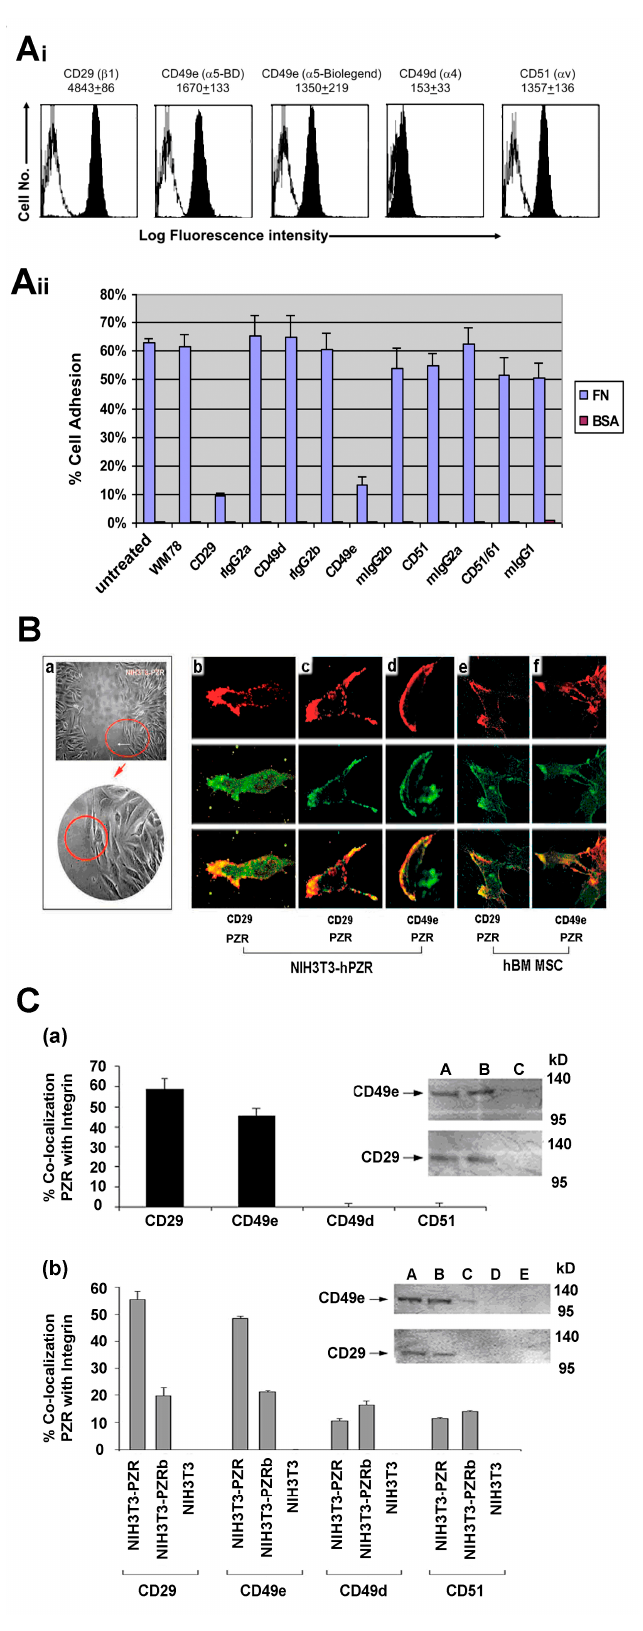
Figure 4. Co-localization of PZR and integrins on migrating NIH3T3 transfectants and hBM MSCs. ( Ai ) Representative FACS histograms of hBM MSCs stained for CD29 ( β 1 integrin), CD49e ( α 5 integrin), CD49d ( α 4 integrin), CD51 (vitronectin receptor), or the relevant isotype control (mIgG1) followed